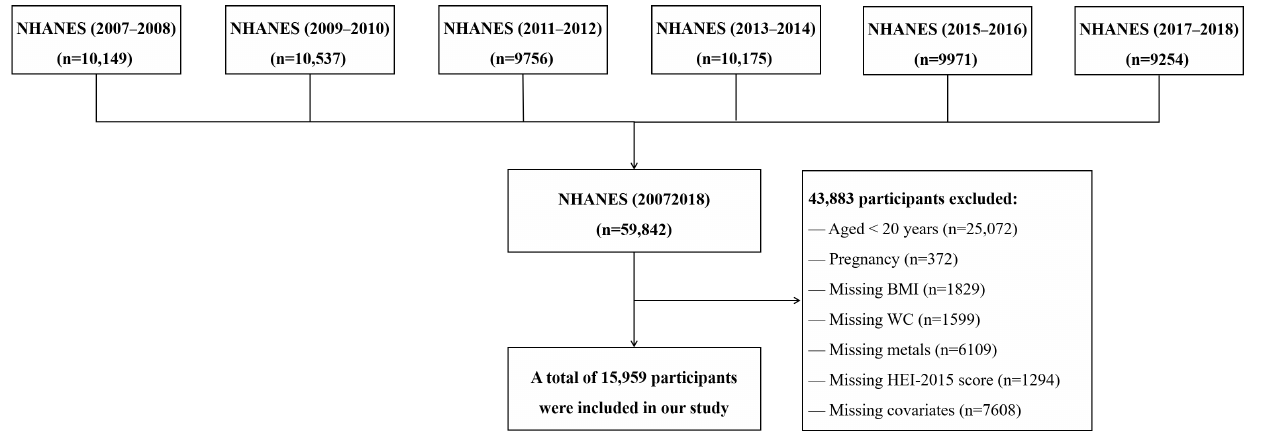
Figure 1. Flowchart of the study population.